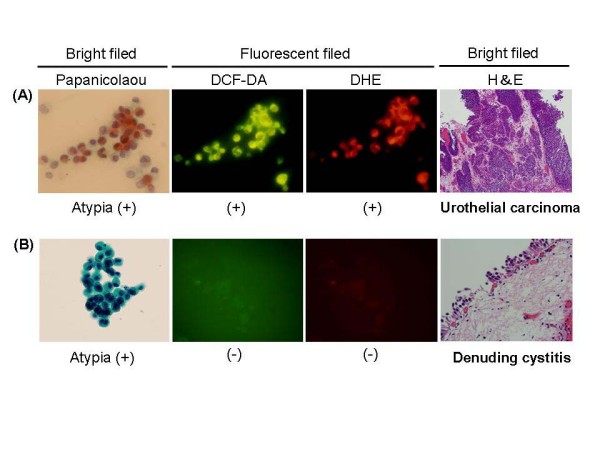
Representative data of ROS urine cytology. (A) Atypical urothelial cell cluster was found under bright field, and these cells were reactive to CM-DCFDA and DHE as determined under fluorescence filed (C-C is poitive and ROS-C is positive). Histological examination of bladder tumors (H&E) revealed superficially invasive/high grade urothelial carcinoma (pT1). (B) Cluster of atypical small sized urothelial cells were found under bright field, but intracellular ROS was not determined (C-C is 'suspicious' but ROS-C is negative). Histology of bladder specimen (H&E) revealed denuding cystitis without malignant findings.